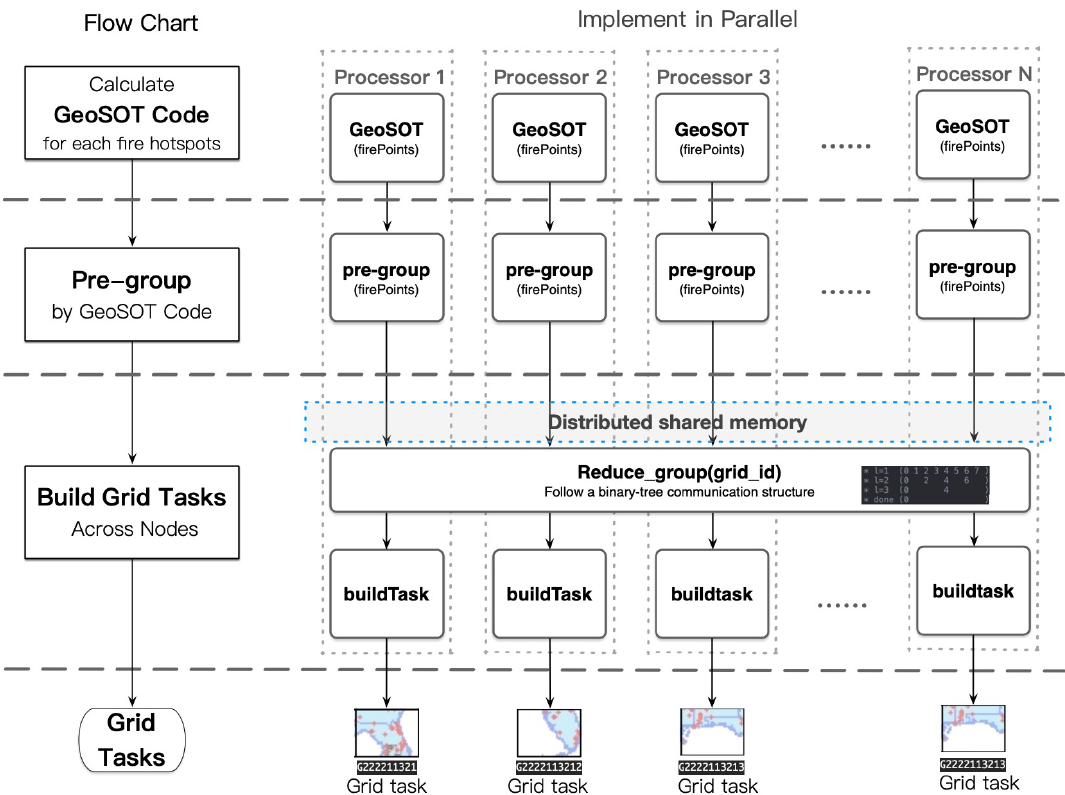
Figure 4. Flow chart and parallel implementation of pre-grouping based on GeoSOT global